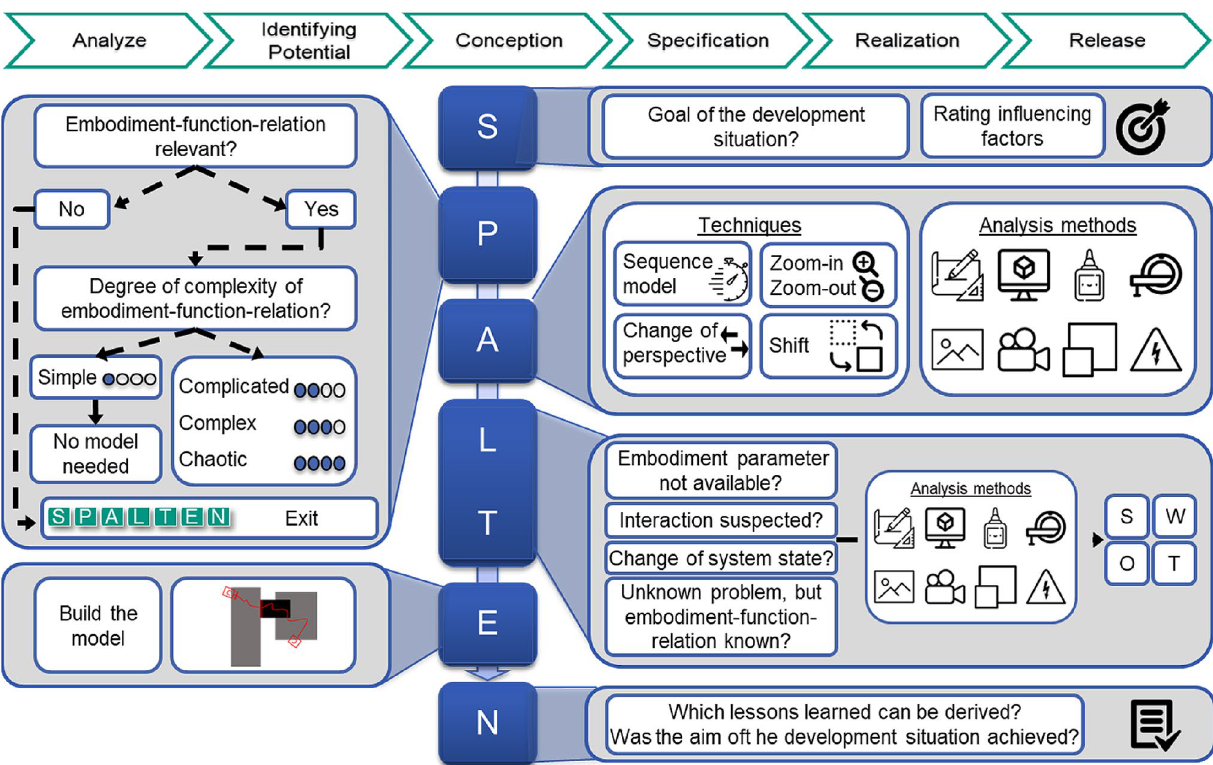
Fig. 6 Overview of the developed